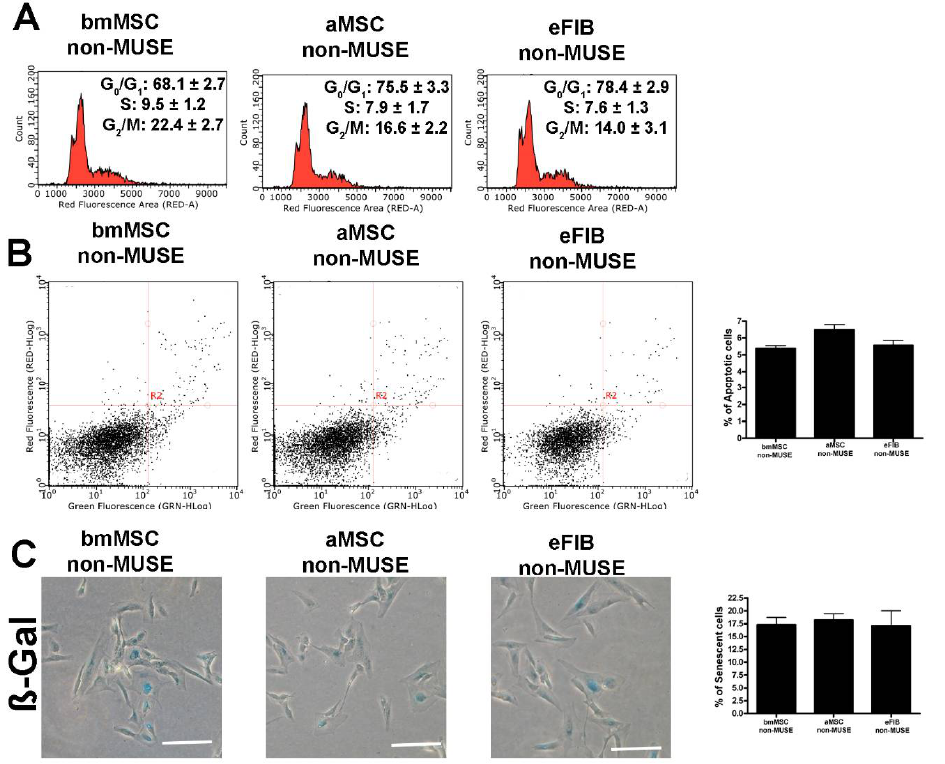
Figure 3. ( A ) Representative cell cycle analysis of the non-MUSE cells isolated from different tissues. The percentages of different cell populations (G1, S, and G2/M) are indicated. ( B ) Representative analysis of non-MUSE cells’ apoptosis. The assay identifies early (Annexin V + and 7ADD −) and late (Annexin V + and 7ADD +) apoptosis. Apoptosis is a continuous process, and we calculated the percentage of apoptosis as the sum of early and late apoptotic cells. The histogram shows the mean percentage of Annexin V-positive cells. ( C ) The pictures show representative microscopic fields of senescence-associated beta-galactosidase-positive cells (blue) in non-MUSE cell cultures. The histograms show the percentage of senescent cells. All experimental data are represented as mean ± standard deviation (SD) of five independent replicates ( n = 5). We compared the three non-MUSE cells’ populations.